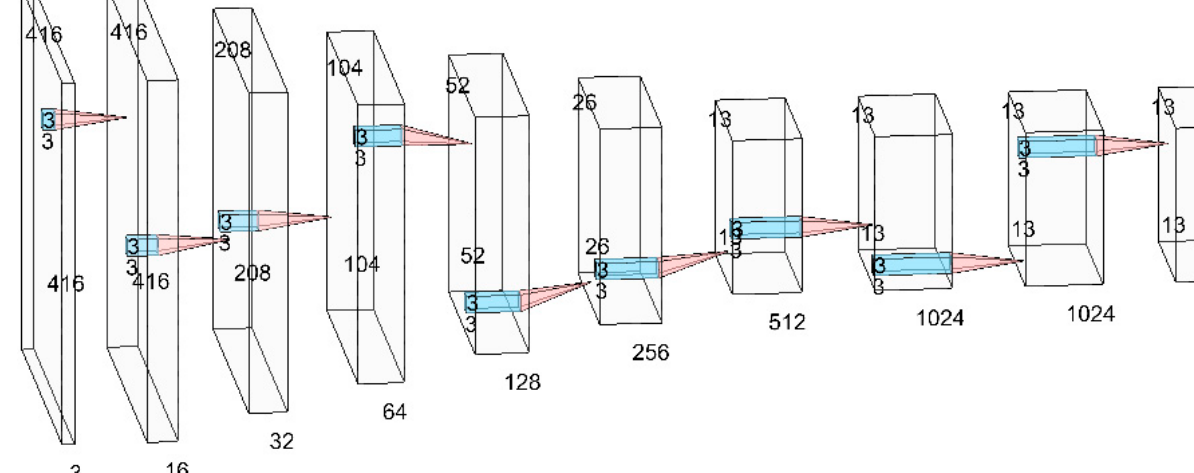
Figure 11. The structure of the tiny-YOLO-VOC model. Table 1. The parameters of tiny-YOLO-VOC structure.